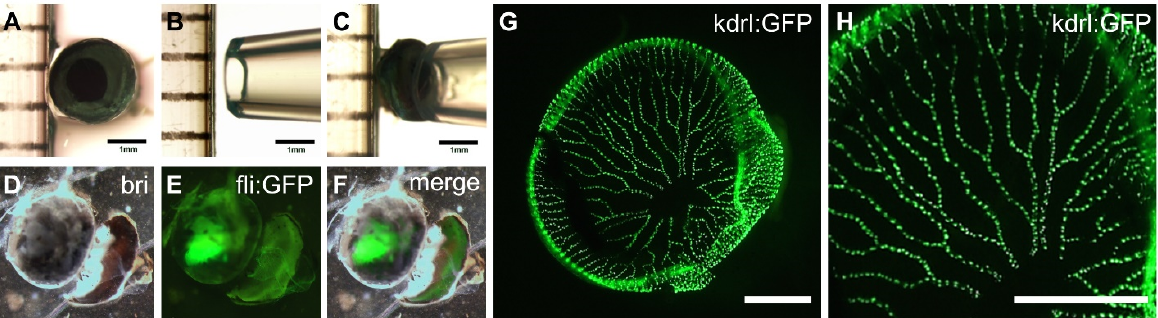
Figure 1. A rapid and simple method for the separation of the intact retinal vasculature from adult zebrafish eyes. ( A – F ) The simple procedure of detaching the whole retinal vasculature from a dis- sected eye using a 1 mL micropipette tip. After the removal of the lens, the intact retinal vasculature was examined by high-resolution microscopy. ( G , H ) Fluorescent image of whole retinal vasculature separated from adult transgenic zebrafish line Tg[kdrl:EGFP] , showing fine blood vessel structures. Scale bars; 1 mm for ( A – F ) and 200 μ m for ( G , H ).